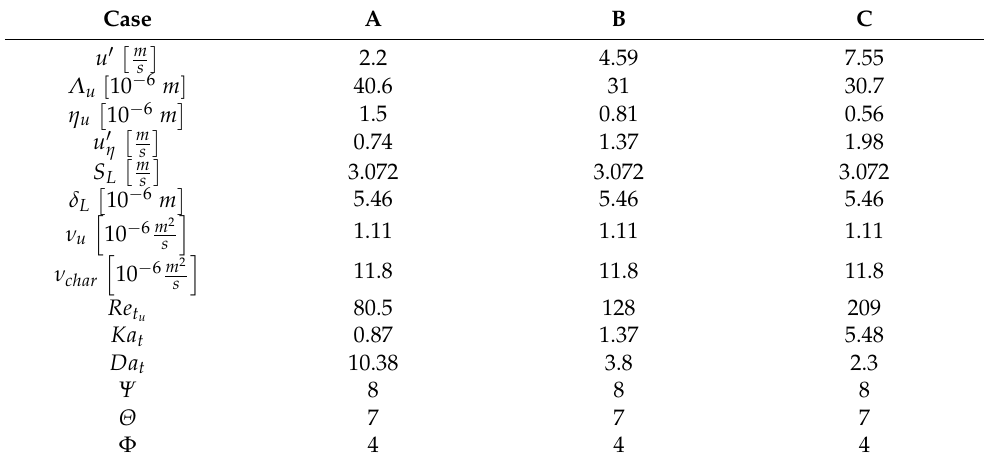
Table 1. Characteristics of the simulated